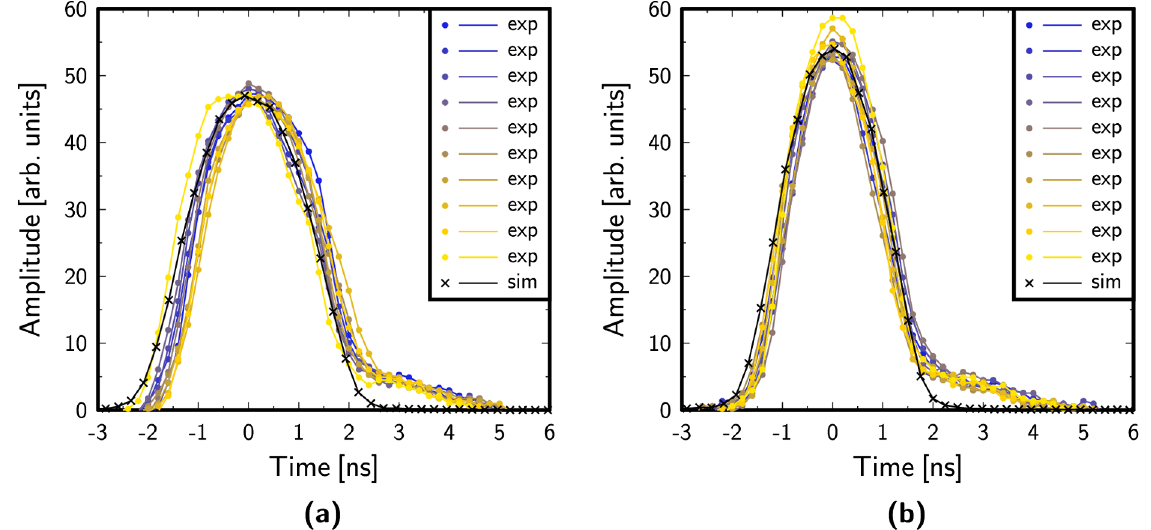
FIG. 1. Bunch profiles measured in the PS after rotation, during the last turn before extraction; the profiles of the ten first bunches in the bunch train (dots) are shown in each case. For comparison, the corresponding simulated profiles (crosses) are shown as well. The tails seen on the right-hand side are artifacts of the measurement. Part (a) shows a case with operational rotation settings, while in (b) a higher voltage has been applied to obtain a shorter bunch length. The longitudinal emittance (measured before the bunch splitting and rotation) is practically the same in both cases. Despite the shorter bunch length in (b), the transmission did not improve. The SPS bucket is 5 ns